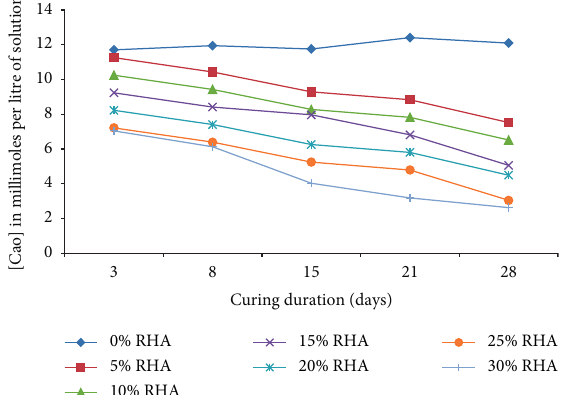
Figure 2: Concentration of CaO in RHA-PC-blended